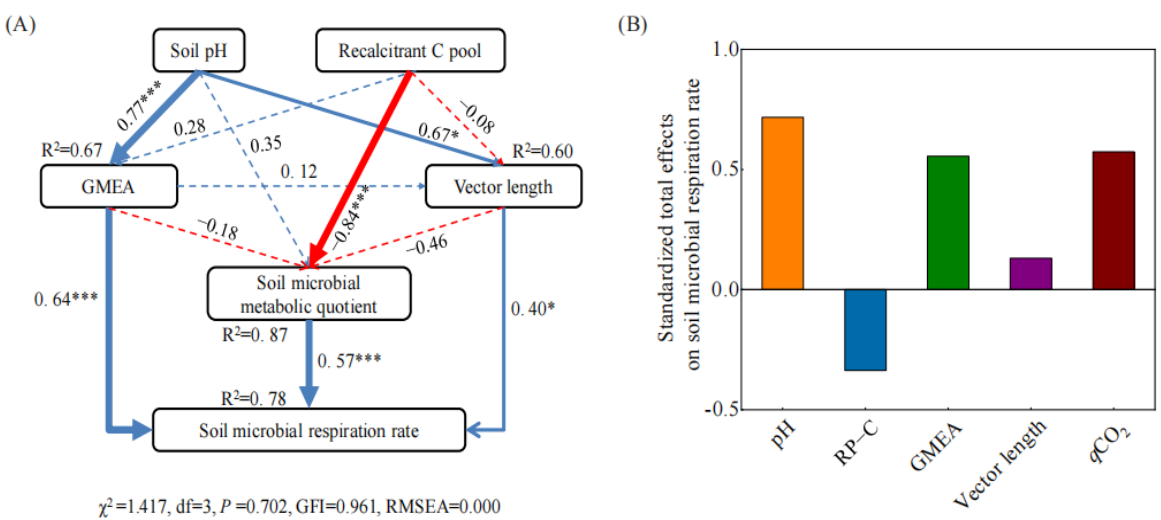
Figure 6. Structural equation model (SEM) showing the direct and indirect effects of soil pH, recal- citrant C pool, GMEA, vector length, and soil microbial metabolic quotient ( q CO 2 ) on soil microbial respiration rate ( A ). The standardized total effects (direct plus indirect effects) calculated by the structural equation model ( B ). Continuous and dashed arrows indicate significant and insignificant relationships, respectively. The width of the arrows is proportional to the strength of path coeffi- cients. Blue and red arrows indicate positive and negative correlations, respectively. Significant level: *, p < 0.05; ***, p < 0.001.